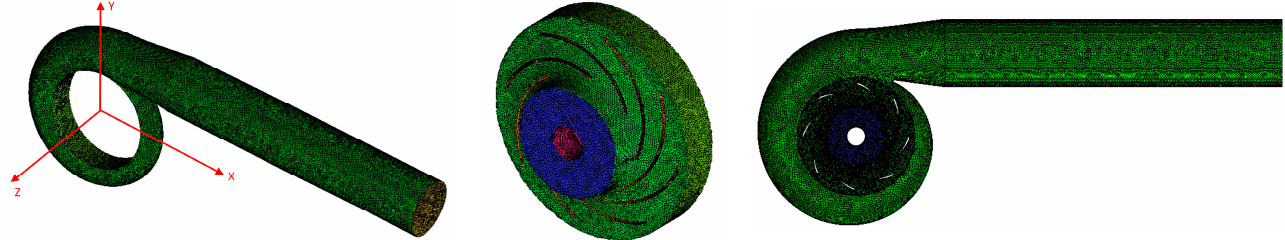
Figure 2. The model of fluid domain and the grid division.